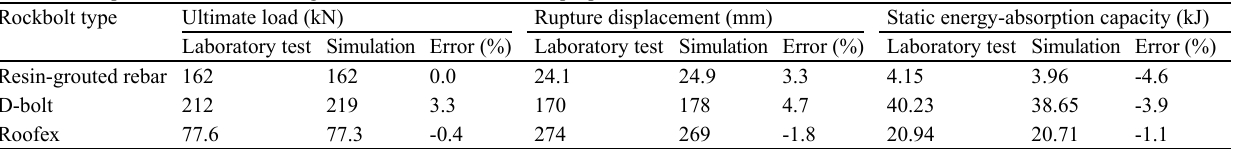
Table 6 Comparison between the targeted and simulated rockbolt properties Rockbolt